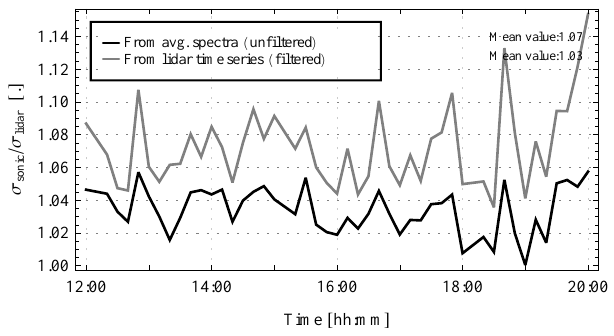
Fig. 6. Comparison of standard deviations obtained from the lidar time series (gray) and from the average Doppler spectrum (black) with respect to the sonic standard